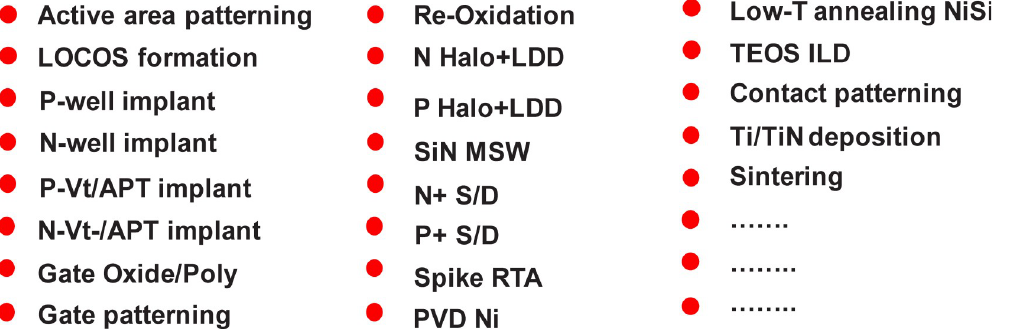
Fig 1. The traditional 90 nm standard CMOS process. This process requires more than one hundred steps. There can be several hundred parameters in the fabrication flow. Abbreviations: Low-T—low temperature, LOCOS- local oxidation of silicon, Halo+LDD—halo-type lightly doped drain, TEOS ILD-tetraethoxysilane interlayer dielectric, MSW- major sidewall spacers, Vt/APT- threshold voltage for anti-punch through, poly- polysilicon, S/D- source/drain, RTA- rapid thermal processing, PVD- physical layer deposition, and N+/P+—n-type /p-type